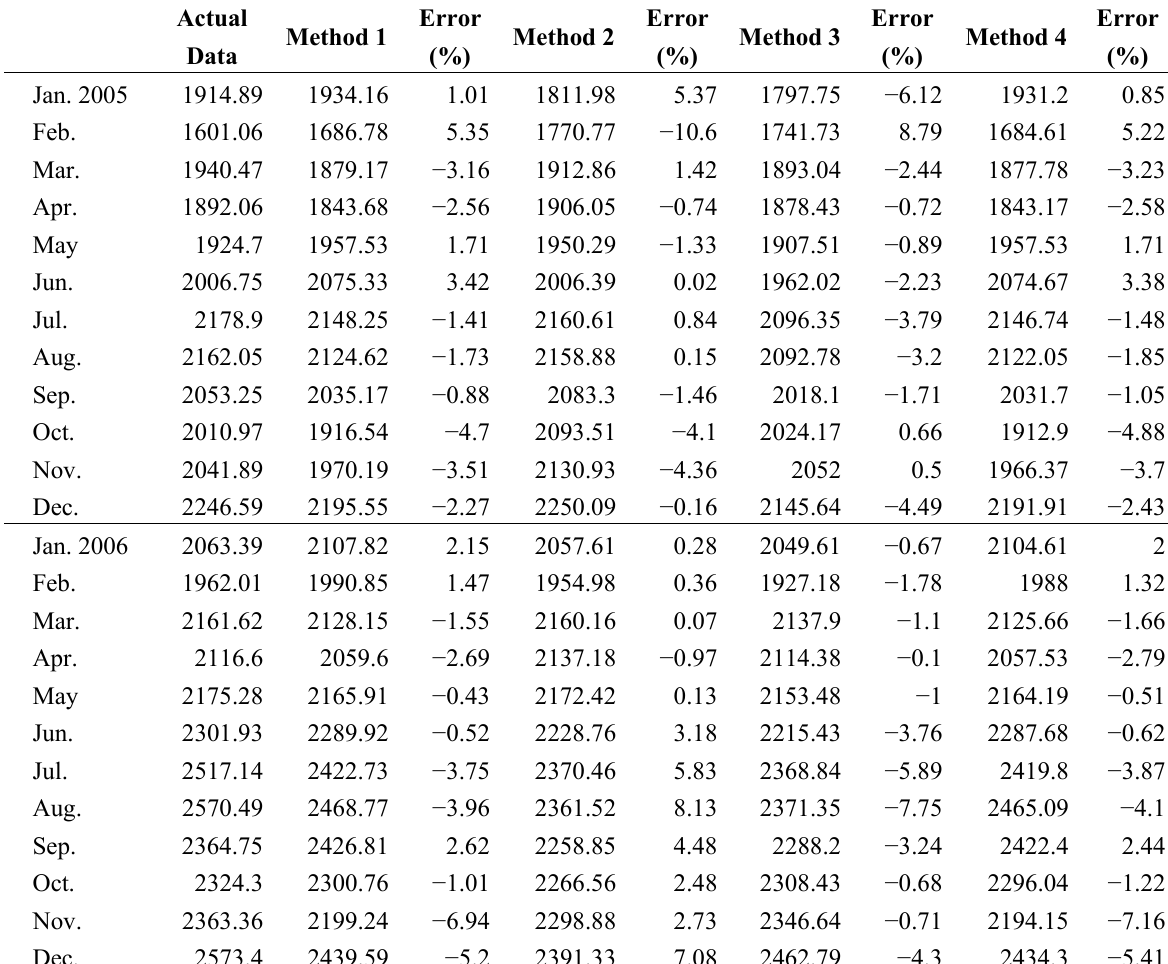
Table 1. Analysis of forecasting